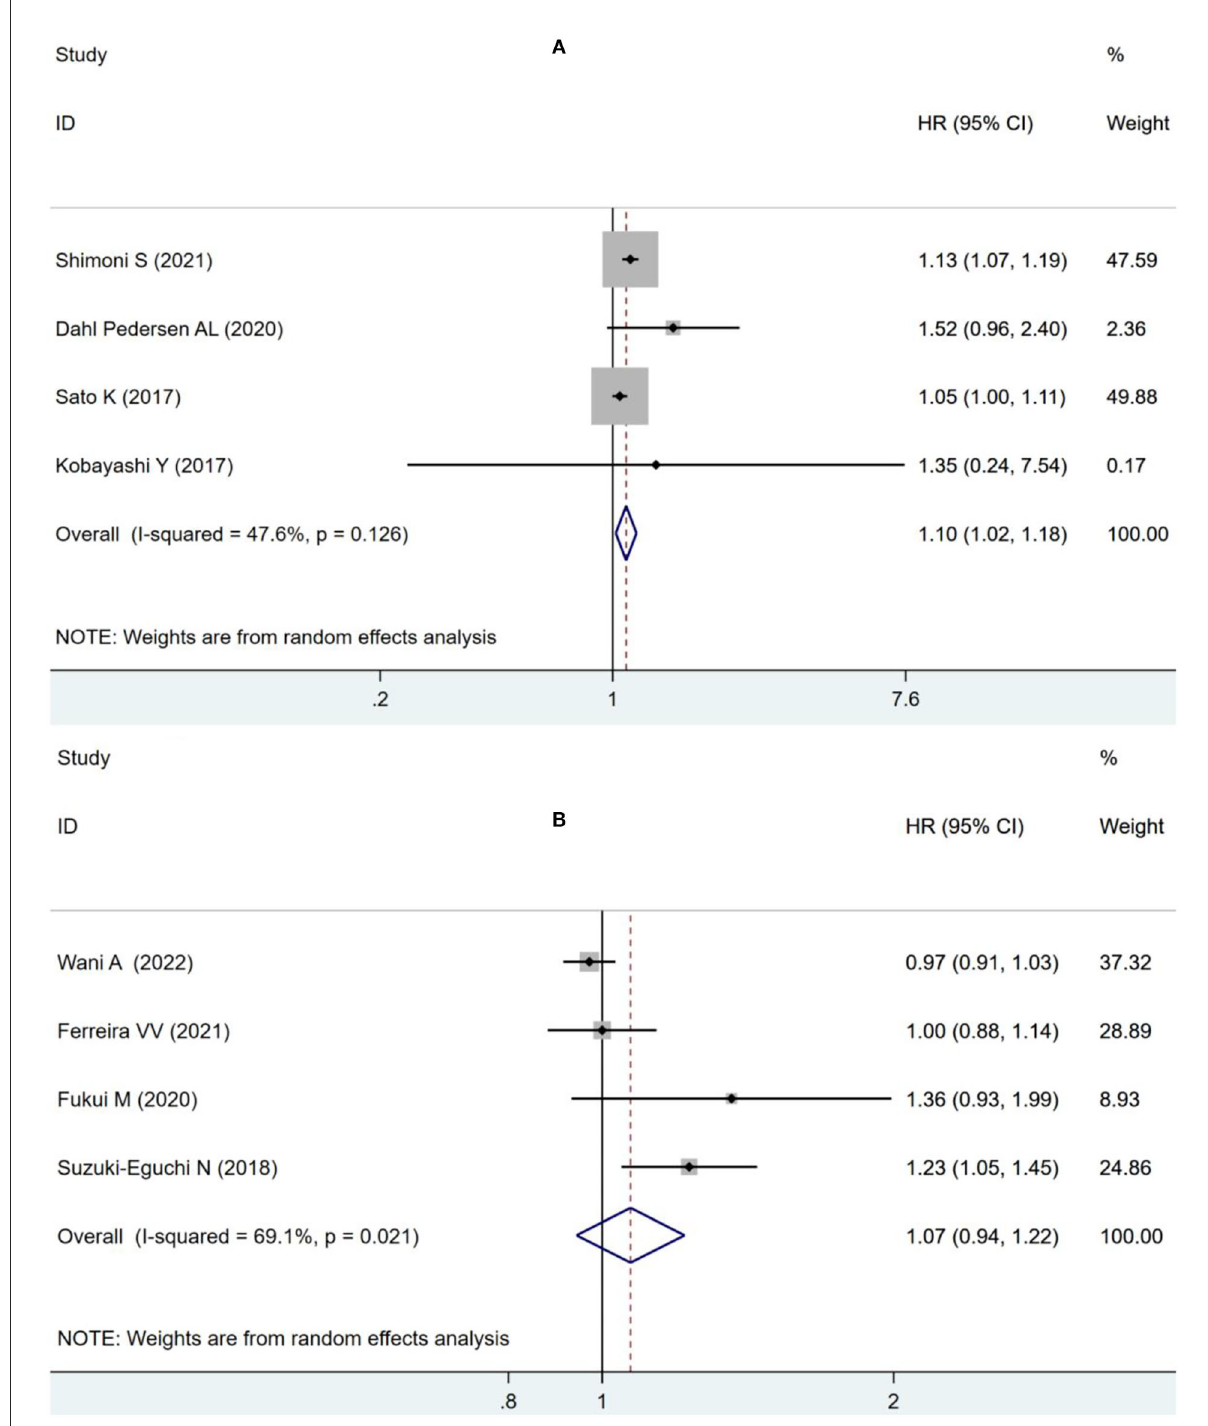
FIGURE5 Forest plot demonstrating the association between LVLS and combined ACM and MACE in patients with AS undergoing TAVR in the LVEF < 55% group (A) and in the LVEF ≥ 55% group (B)